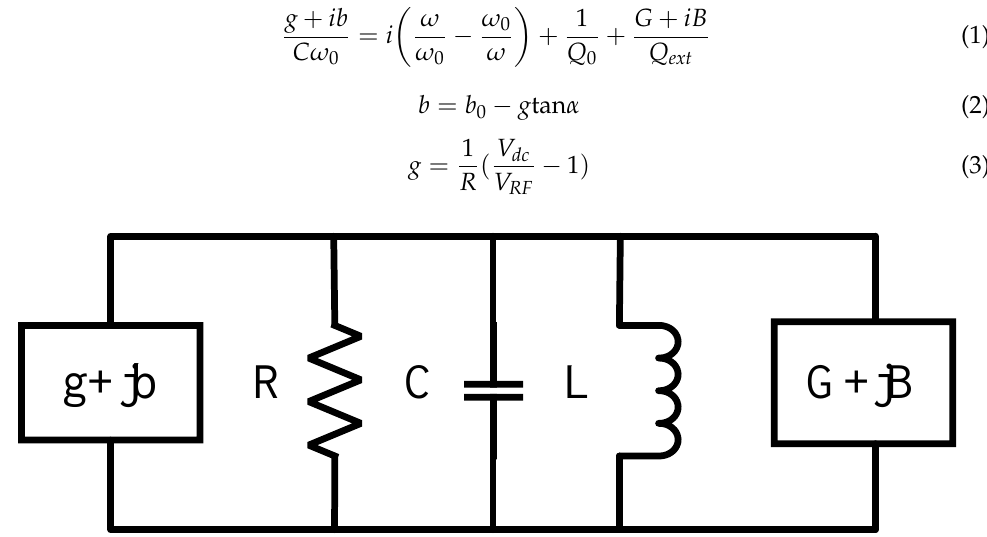
Figure 1. Equivalent circuit of magnetron.